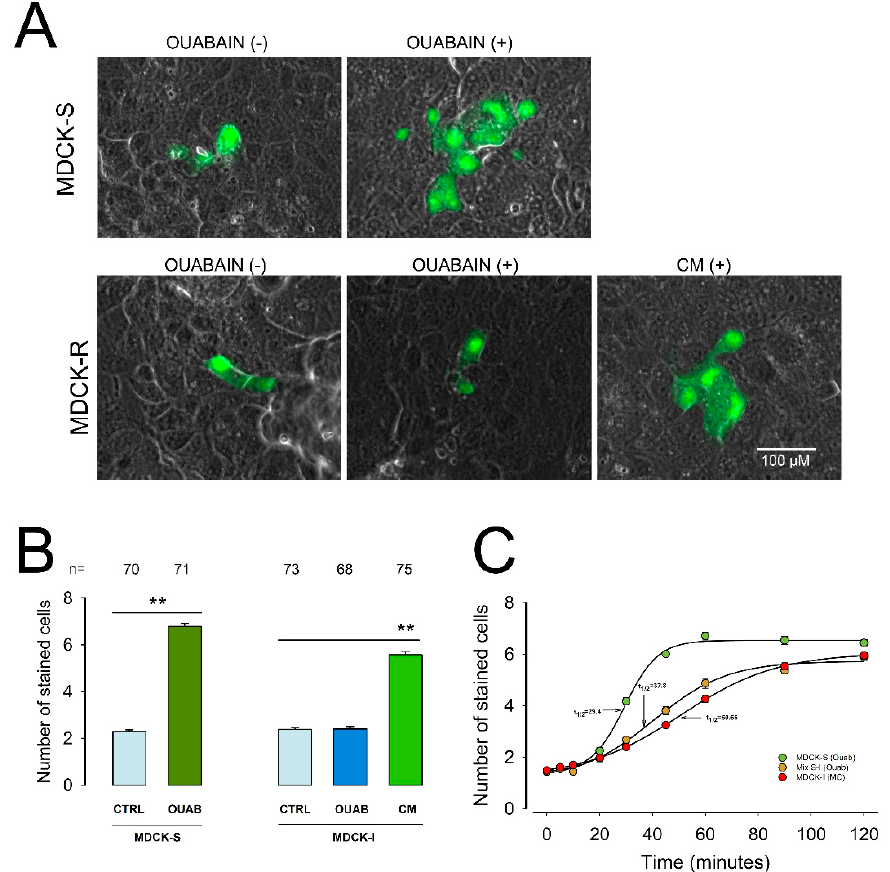
Figure 2. Ouabain induces in MDCK-S cells, secretion of a compound that stimulates GJIC in cells insensitive to the direct action of ouabain (MDCK-I). ( A ) Images showing representative examples of dye transfer trials. The green mark corresponds to LY, whereas the gray background is a phase contrast field showing the integrity of the monolayer. The images were selected to match the median of each indicated experimental condition. ( B ) Bar chat comparing the average value of the number cells stained with LY ( X SC ) with and without treatment with ouabain (OUAB) in monolayers of MDCK-S and in in monolayers of MDCK-I treated with Ouabain or wit conditioned media (CM). The values above bars indicate the number of repetitions. (**) indicates statistically significant difference ( p < 0.001) of the groups indicated by lines ( C ) Plot comparing the time course of the effect of ouabain in monolayers of MDCK-S or mixed monolayers, or MDCK-I treated with CM produced at distinct times of incubation with ouabain. The continuous lines result from fitting data to a sigmoidal curve by non-linear regression.